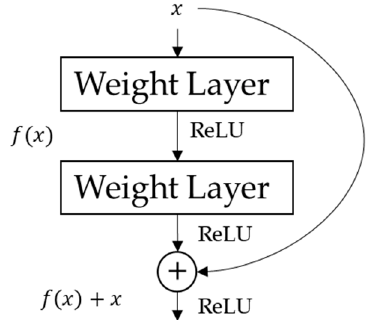
Figure 5. Residual learning process.